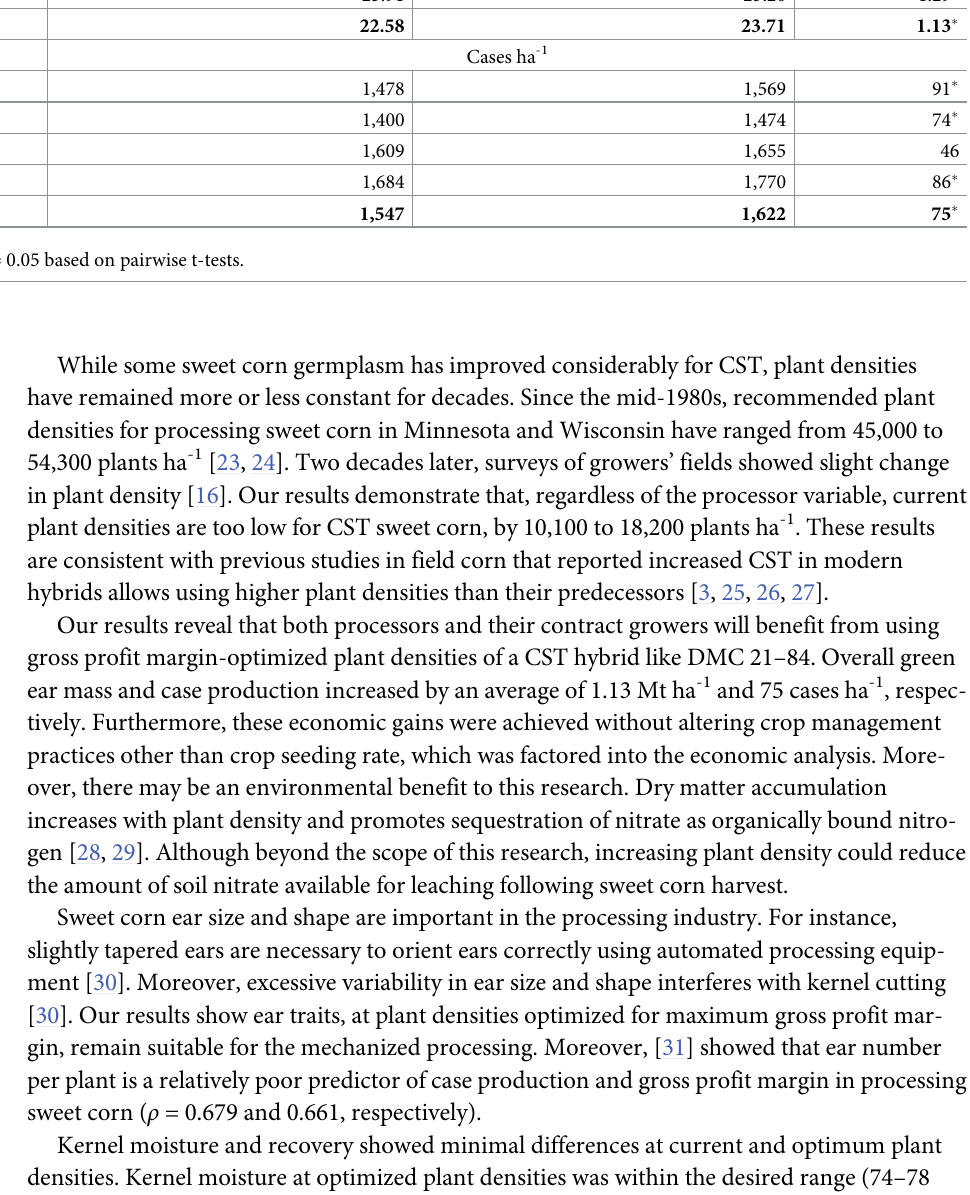
Table 3. Effect of a crowding stress tolerant hybrid on yield traits when shifting from current plant density to plant density optimized for maximum gross profit margin ($ ha -1 ) across different production areas. Yield trait